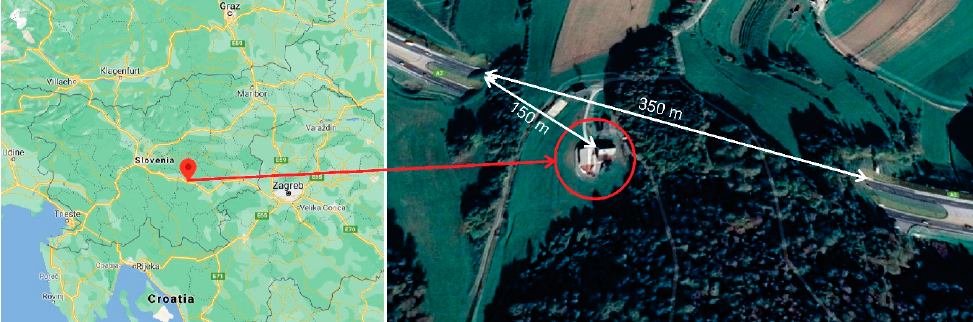
Figure 2. Tunnel tube map—highway Pluska–Ponikve.